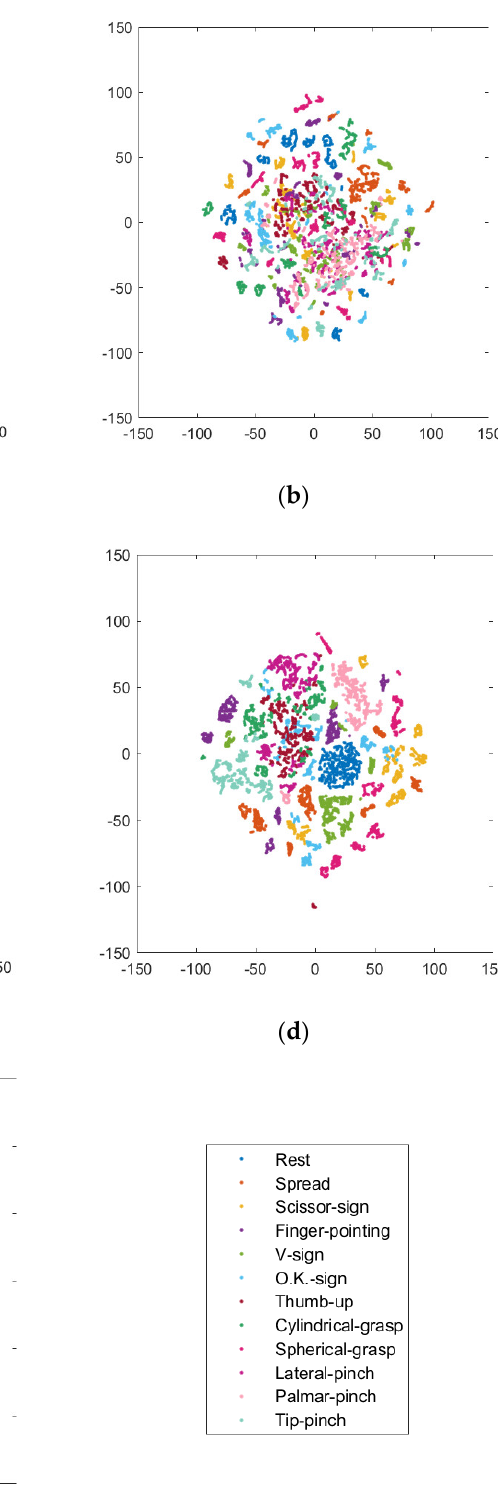
Figure 6. t-SNE visualization of variability in the sEMG signals of a healthy adult (subject 1): ( a ) Day 1, ( b ) Day 2.